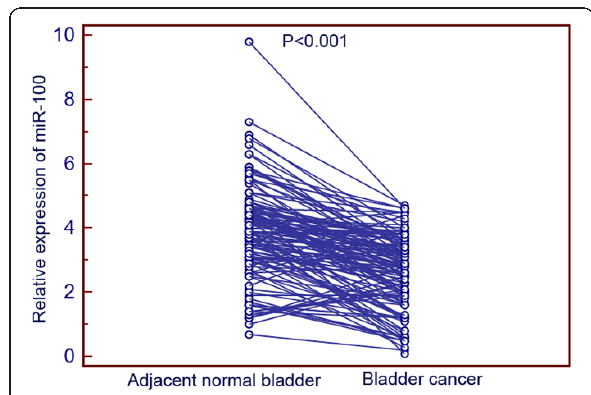
Figure 1 miR-100 expression in 126 pairs of bladder cancer and adjacent normal bladder tissues detected by quantitative real- time polymerase chain reaction (qRT-PCR) analysis.